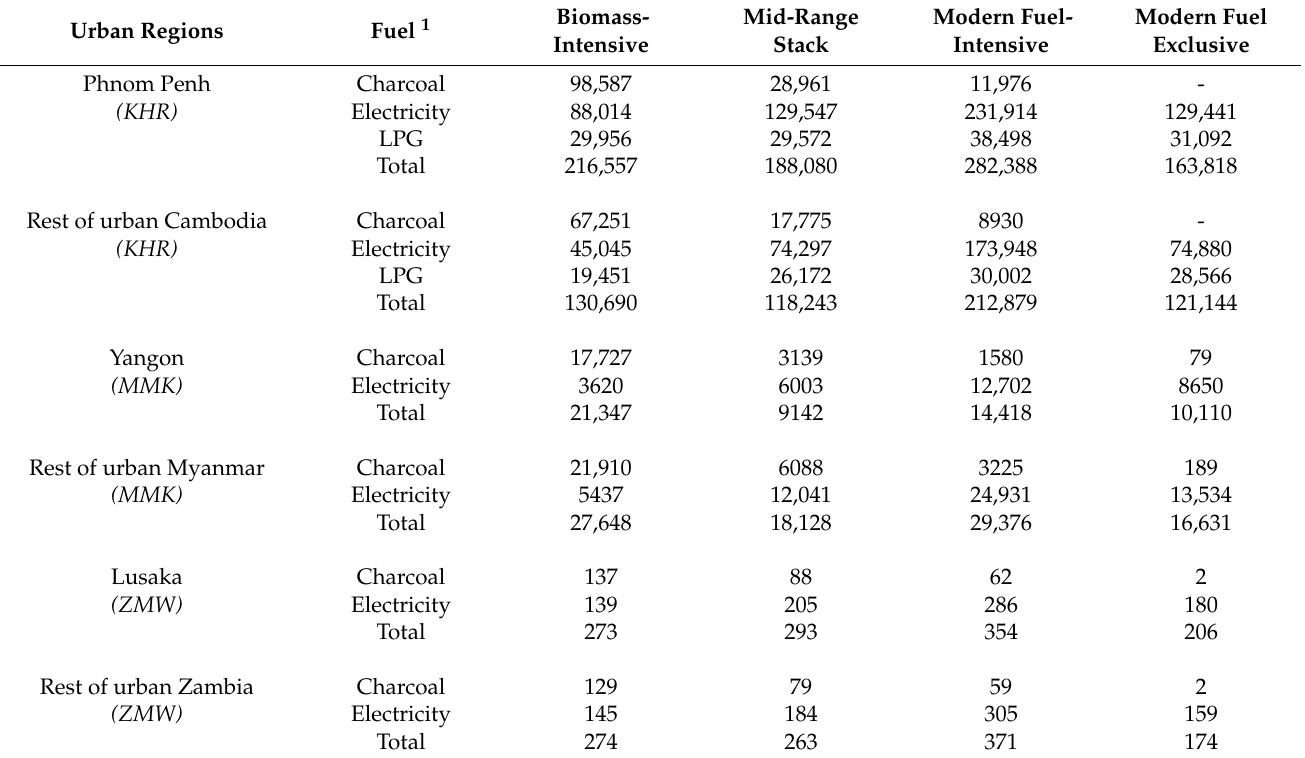
Table 7. Mean monthly fuel expenditures (local currencies: KHR, MMK,